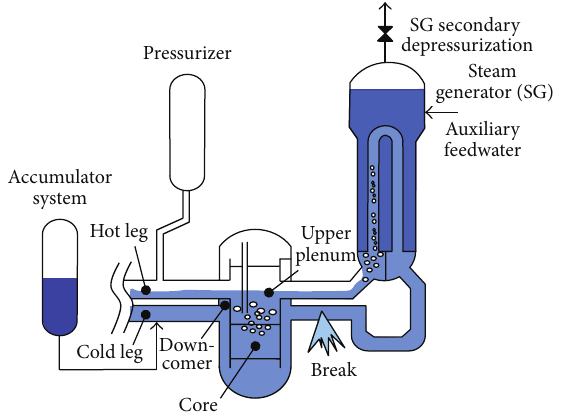
Figure 1: Coolant behavior during PWR cold leg SBLOCA with SG secondary-side depressurization.